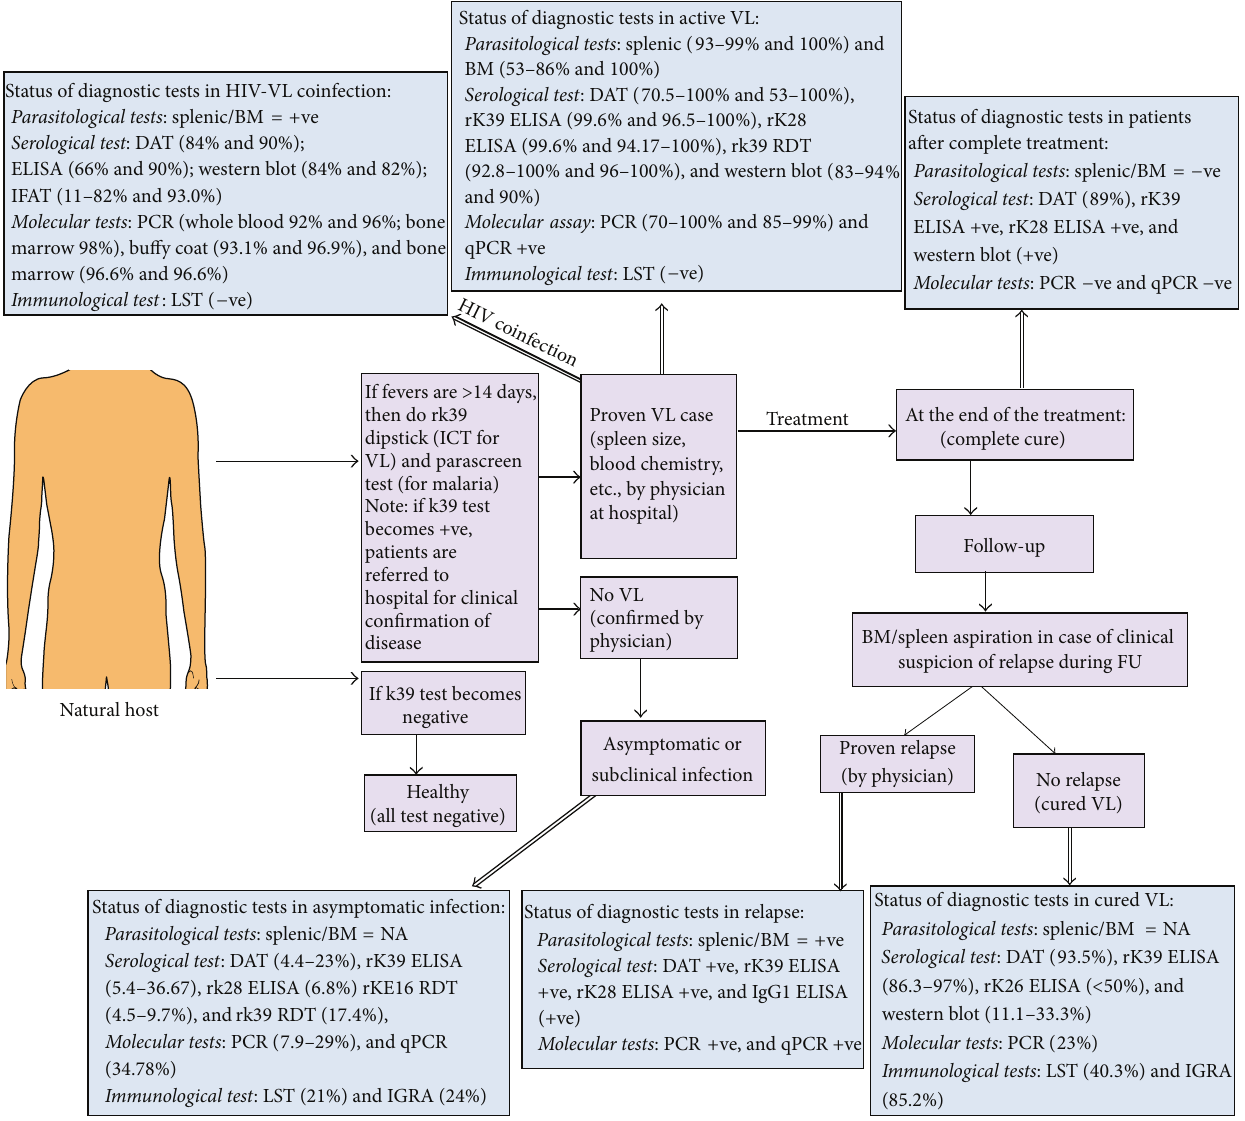
Figure 1: Generalized scheme of disease identification in endemic areas and sensitivity of various diagnostic tests in different pathological condition of VL. +ve: positive; − ve: negative; BM: bone marrow; DAT: direct agglutination test; ELISA: enzyme linked immunosorbent assay; HIV: human immunodeficiency virus; IGRA: interferon- 𝛾 release assay; LST: leishmanin skin test; NA: not applicable; qPCR: quantitative real time PCR; PCR: polymerase chain reaction; VL: visceral leishmaniasis. Note: in the case of VL and HIV-VL coinfection, both sensitivity and specificity of the diagnostic tests are